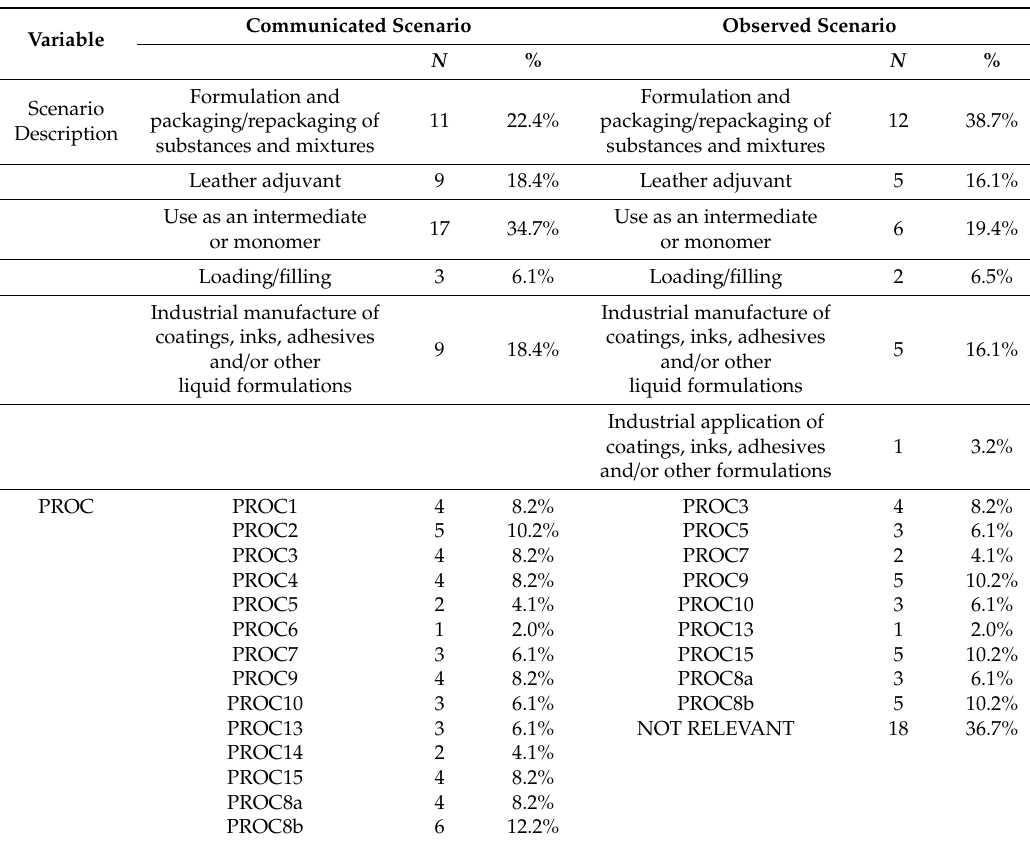
Table 3. Scenarios characteristics represented by scenario name and process categories (PROC) for both the communicated scenario and observed scenario with the number (N) and percentage (%) of each